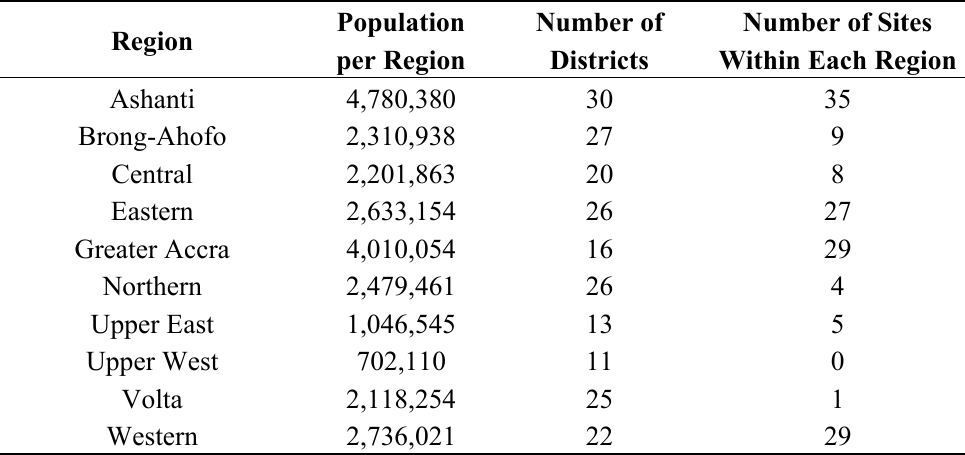
Table 2. Regional divisions of administrative districts and number of contaminated sites